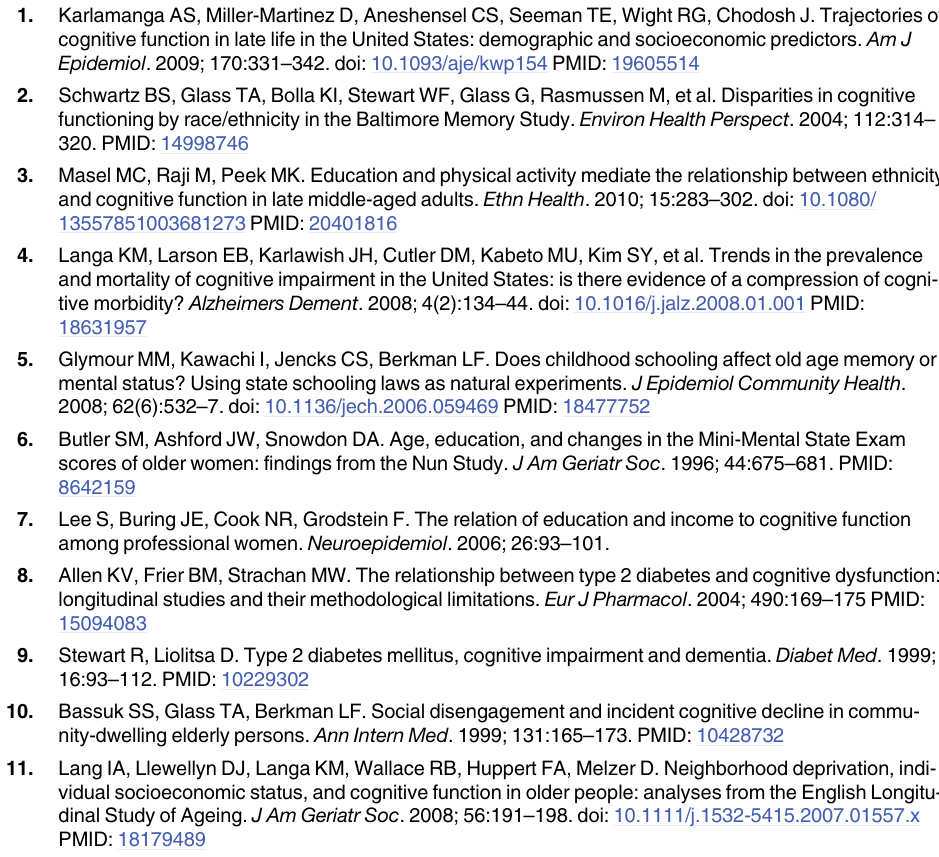
S5 Table. Weighted multivariate linear regression coefficient estimates with varying lag periods between the 1990 U.S. MSA-level Gini coefficient and TICS-m score for individuals assessed at every wave (1998 – 2010), Health and Retirement Study. S6 Table. Weighted multivariate linear regression coefficient estimates with varying lag periods between the 1990 U.S. state-level Gini coefficient and TICS-m score for individuals assessed at every wave (1998 – 2010), Health and Retirement